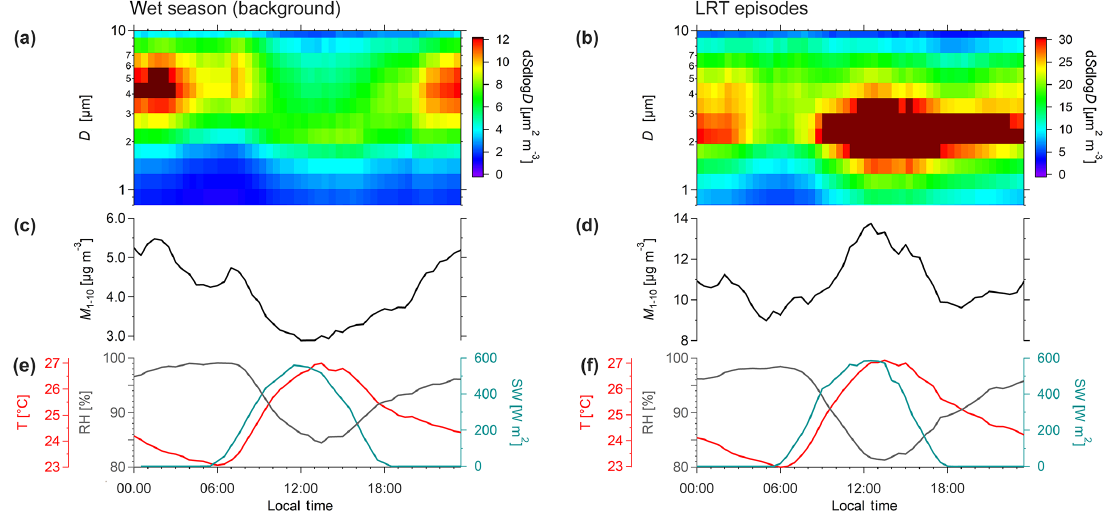
Figure 10. Diurnal cycles in selected aerosol and meteorological parameters during the wet season without major dust influence vs. LRT episodes within the time frame shown in Fig. 9. (a, b) Image plots of aerosol size surface distribution for the size range from 0.8 to 10µm. (c, d) Coarse mode aerosol mass concentration M 1–10 . (e, f) Micrometeorological parameters, temperature, RH, and incoming short-wave solar